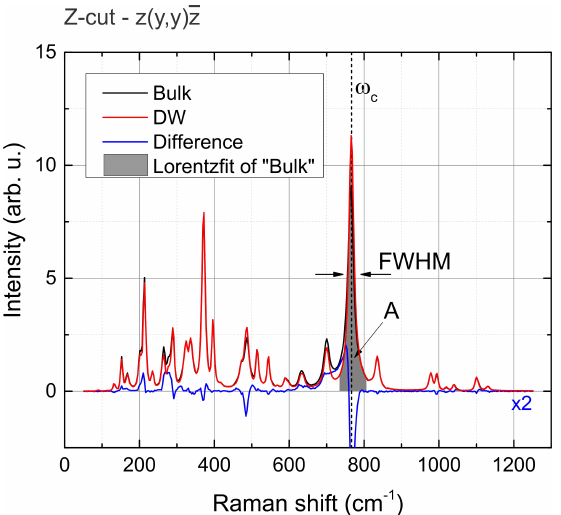
Figure 2. Raman spectra of a DW compared to bulk spectra for the scattering geometry z(y,y)z. For better visibility of the changes, a difference spectrum is